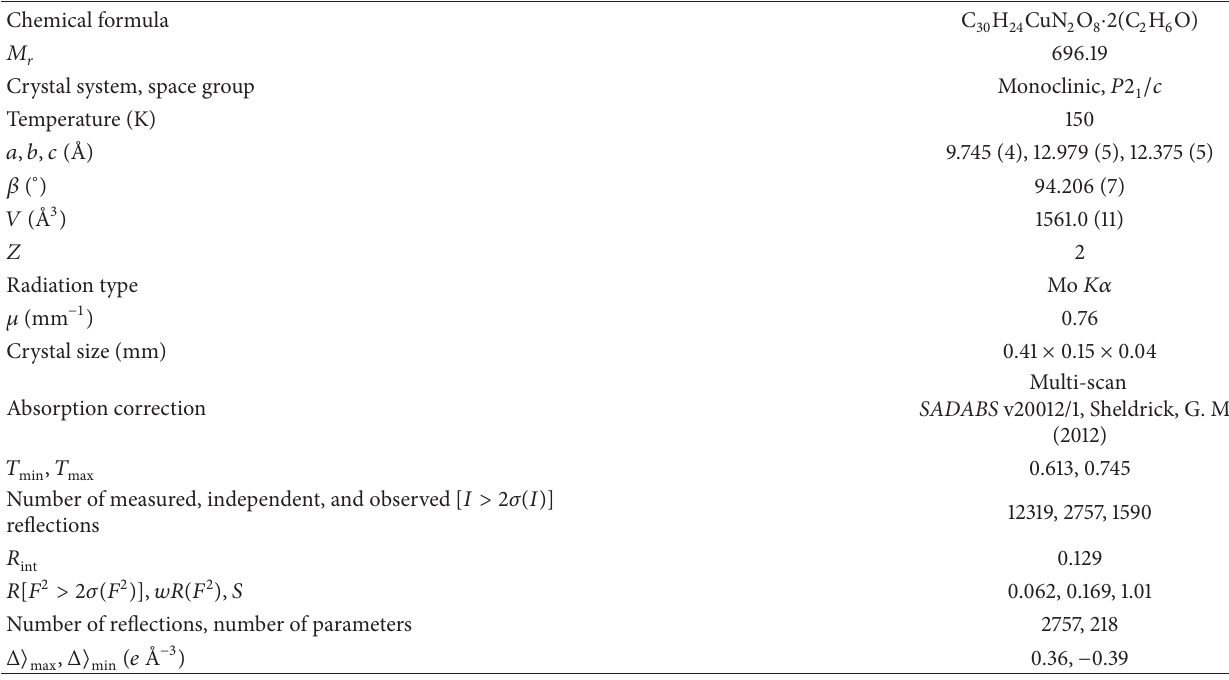
Table 1: Crystal